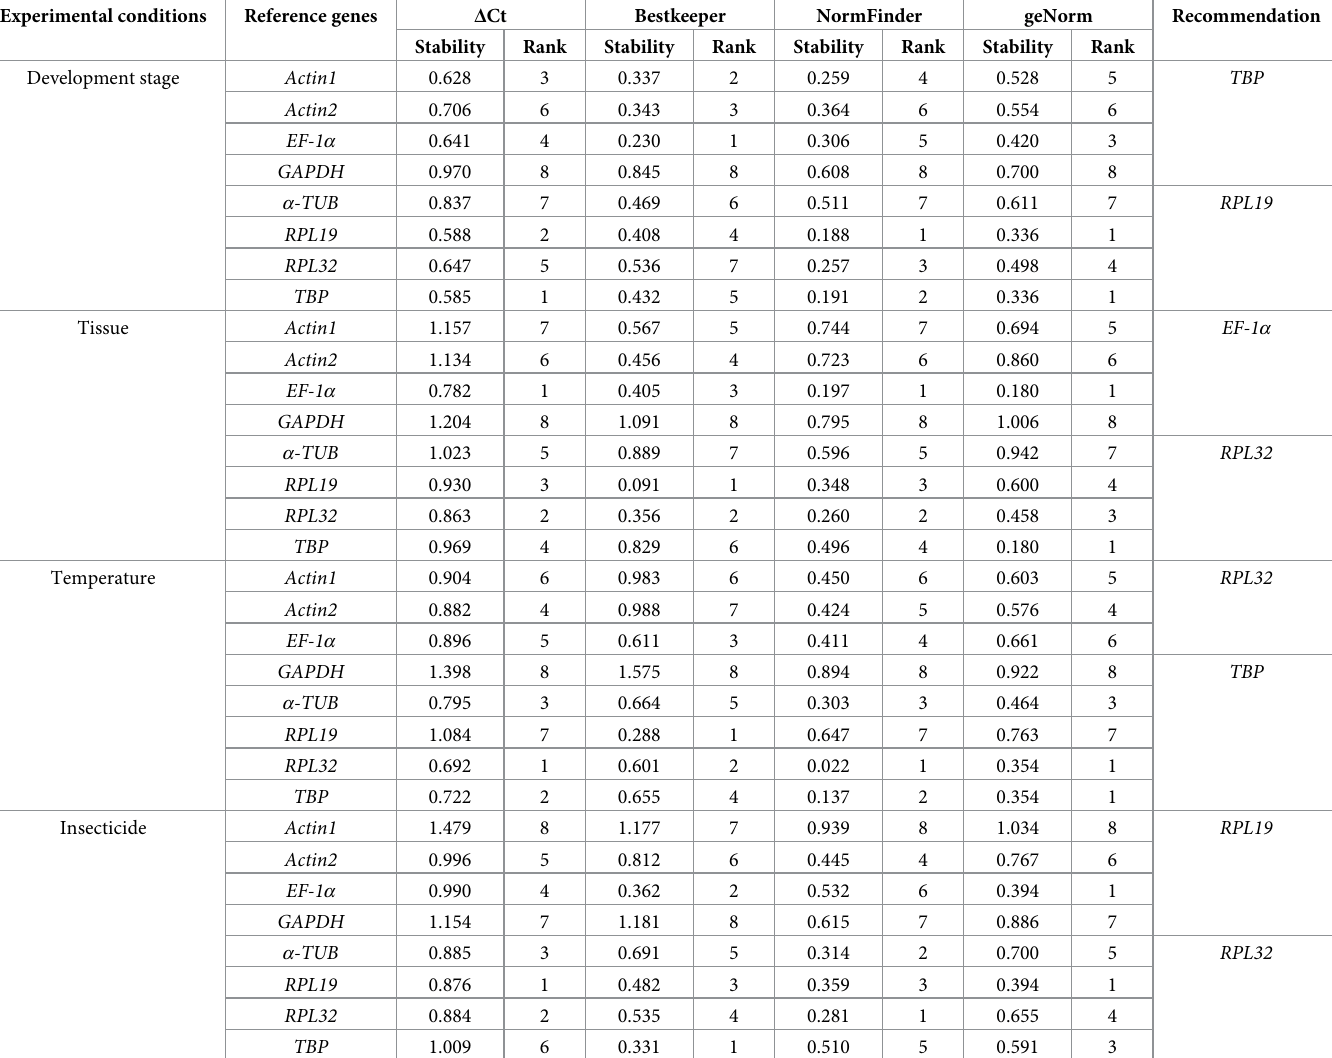
Table 2. Stability of reference gene expression under different experimental conditions calculated by four different analytical tools. Experimental conditions Development stage